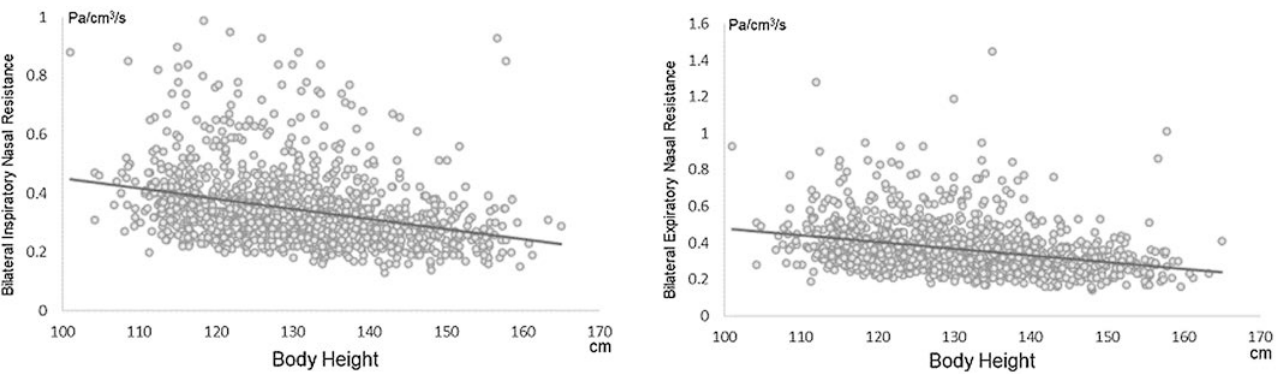
Figure 2 There was a significant negative correlation between body height and nasal resistance on expiration as assessed by linear regression analysis.